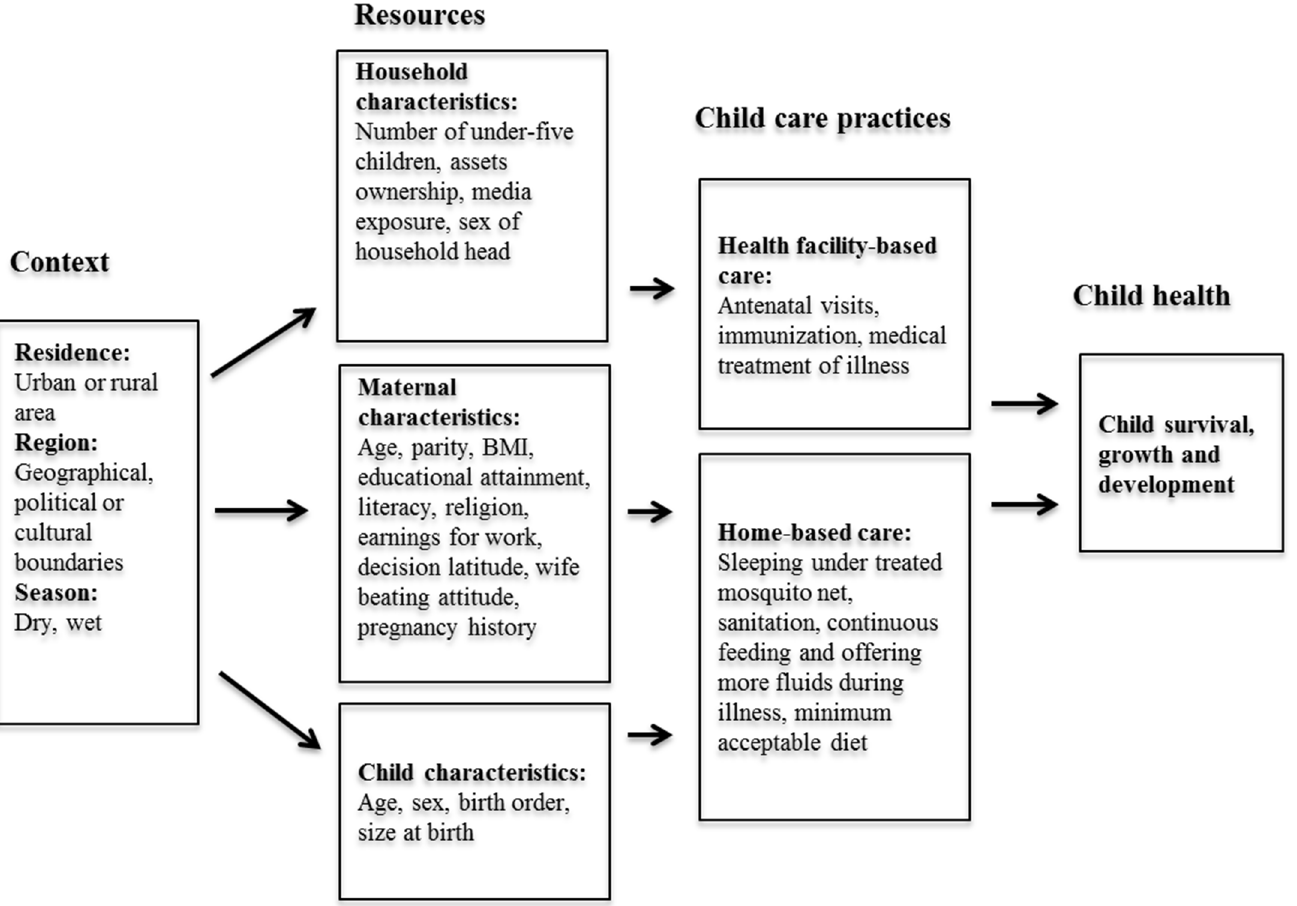
Fig 1. Analytical